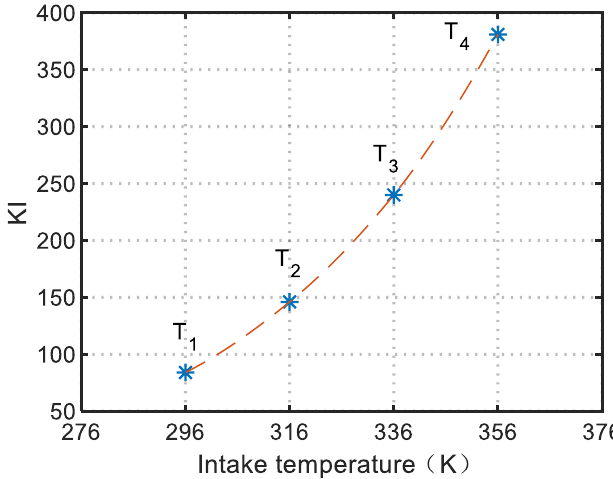
Figure 15. Knock intensity at different intake temperatures.